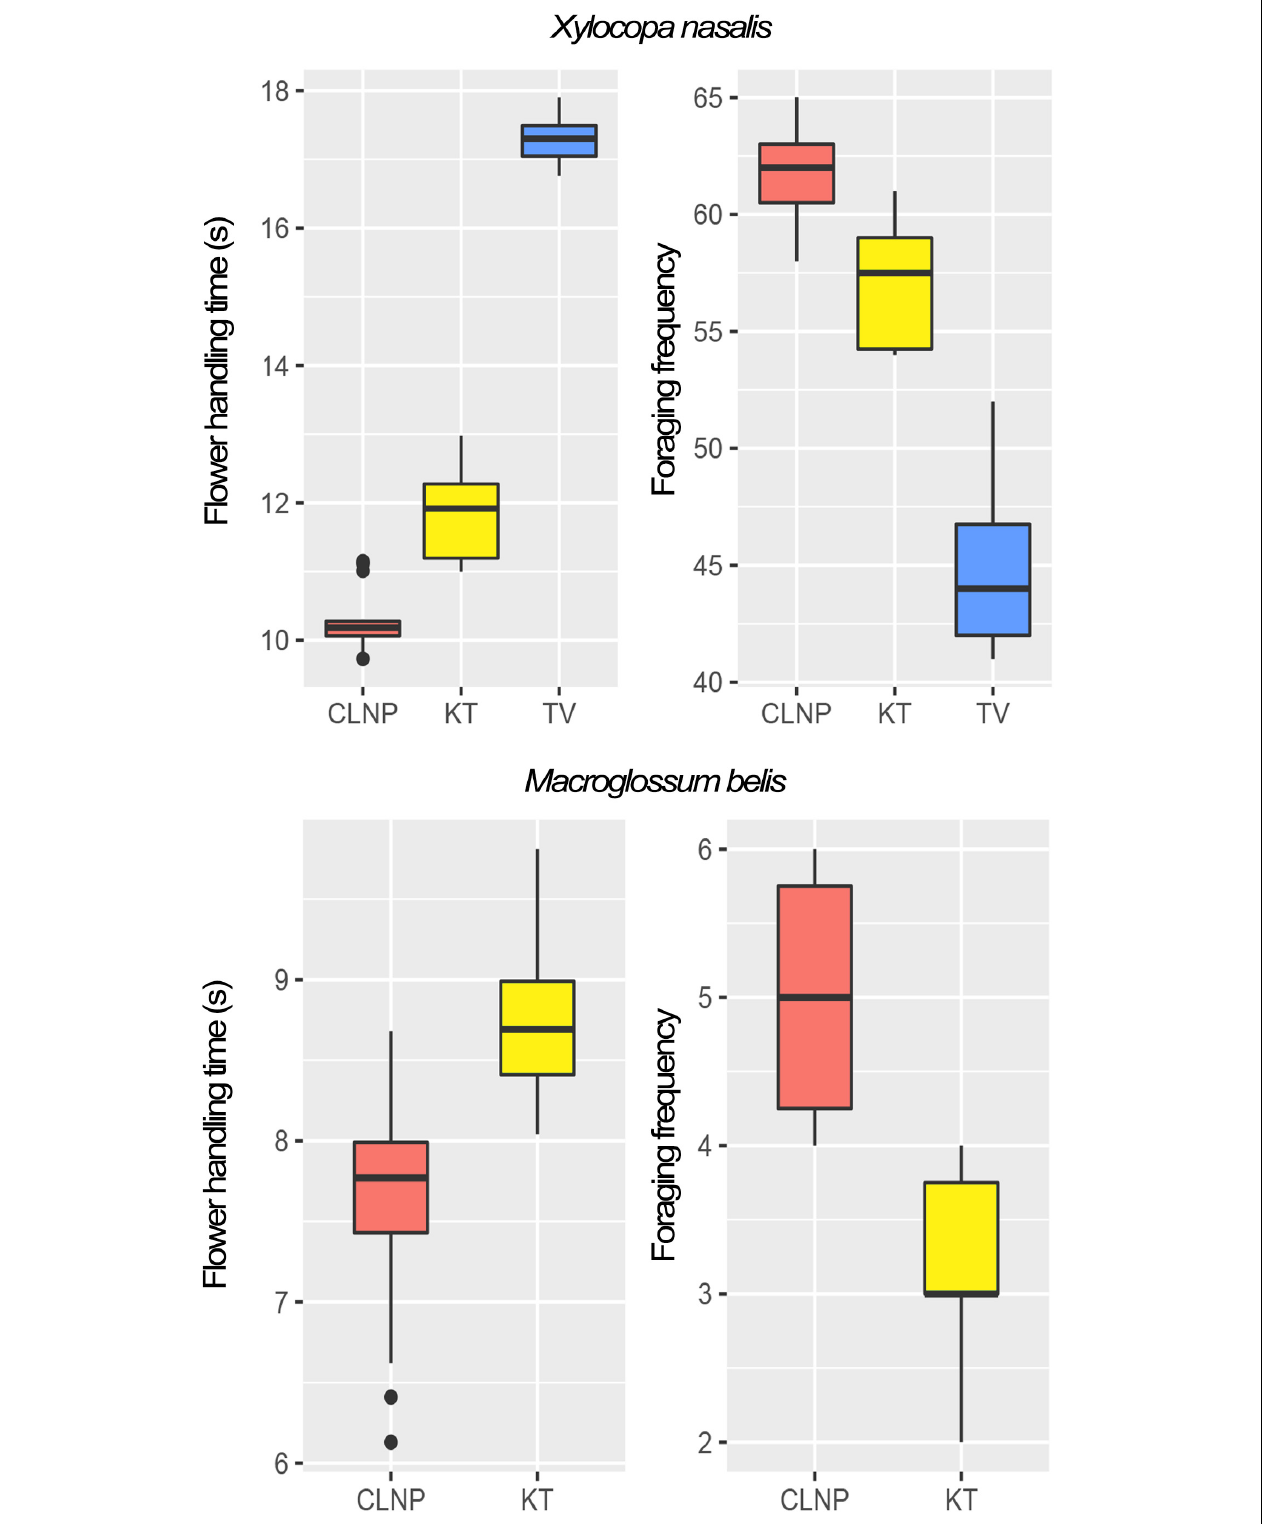
FIGURE 2 | Box-plots depicting the foraging behavior of the pollinator ( Xylocopa nasalis ) and the thief ( Macroglossum belis ), in terms of flowering handling-time (s) and foraging frequency (flowers visited in a bout) in the study populations (CLNP in red; KT in yellow; and TV in blue). At TV, the thief was absent from the foraging guild. CLNP, Clouded Leopard National Park; KT, Kumarghat town; TV, Tlaksih village.